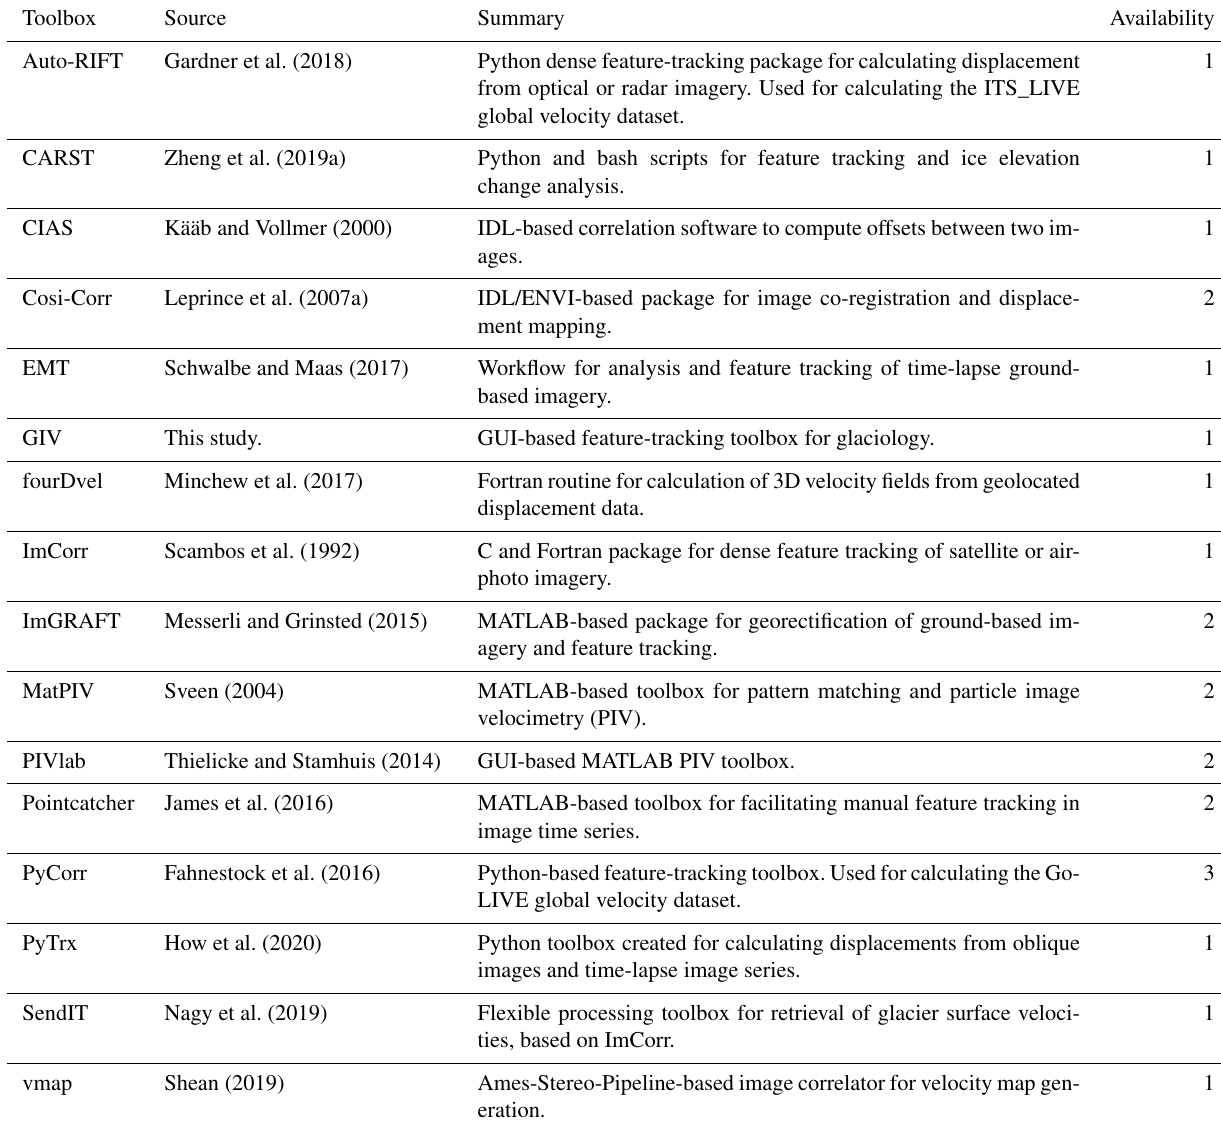
Table 1. Non-exhaustive list of codes and toolboxes that may be used for feature tracking and associated references. For availability, 1 = fully available, 2 = available but relies on commercial software, and 3 = not available. A spreadsheet with download links is available in the